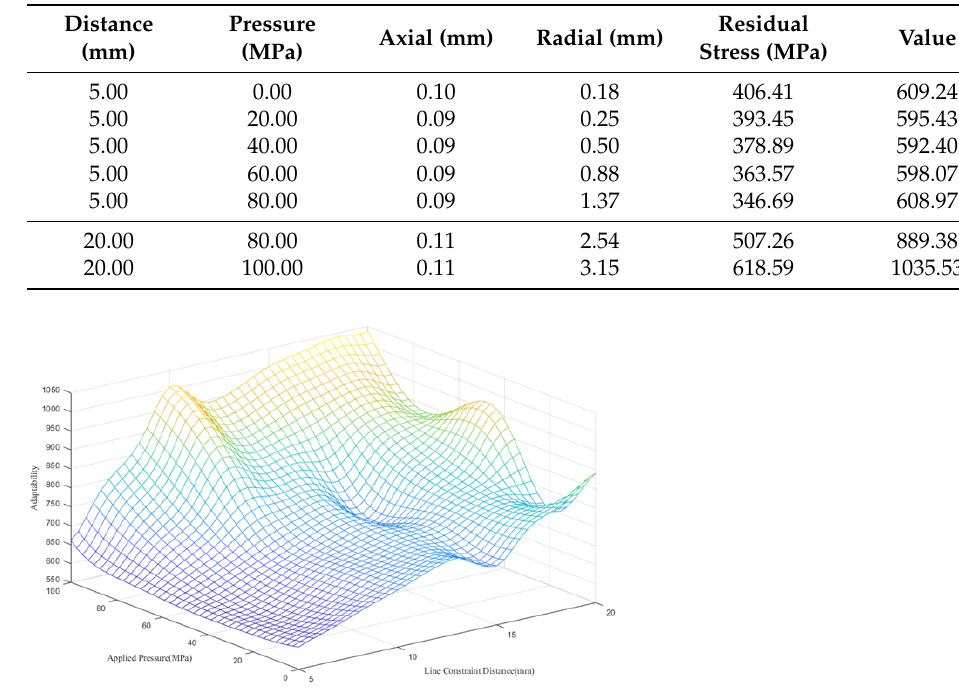
Table 4. Comprehensive evaluation value corresponding to line constraint and applied pressure.